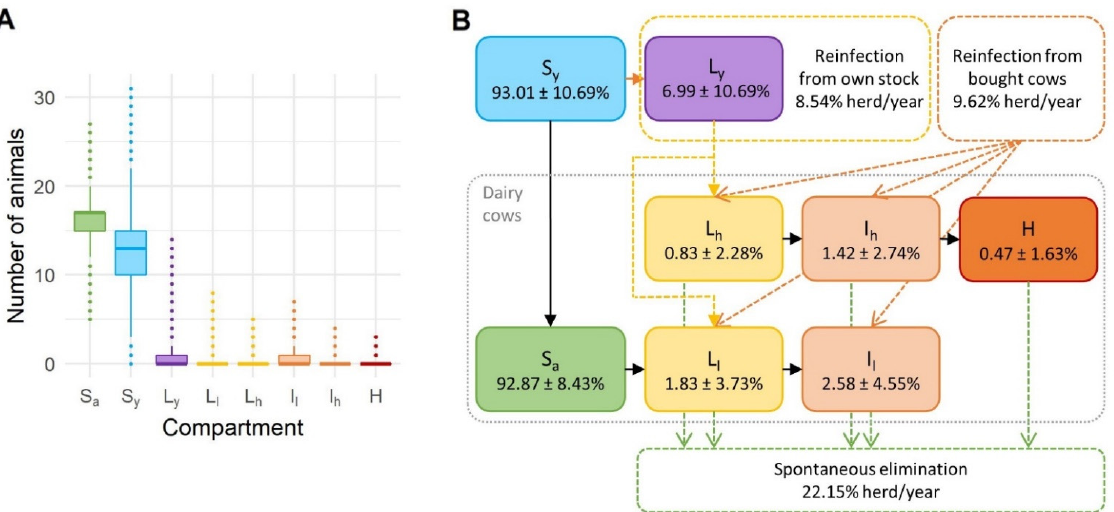
Figure 3. Distribution of animals in individual health states in the model for the spread of Mycobacterium avium subsp. paratuberculosis in a typical Slovenian dairy herd. ( A ) Number of animals individual health states. ( B ) Flow diagram of the model showing the proportion of cows in each health state out of the total number of dairy cows in a herd and the proportion of young female calves and heifers in the two young animal states (mean ± standard deviation). The possible reinfections and spontaneous eliminations (mean per herd/year) are marked with dashed lines. Susceptible cows ( S a ); susceptible young (S y ); latent young ( L y ); latent cows on low shedding pathway ( L l ); latent cows on high shedding pathway ( L h ); infected cows on low shedding pathway ( I l ); infected cows on high shedding pathway ( I h ); high shedders (H).